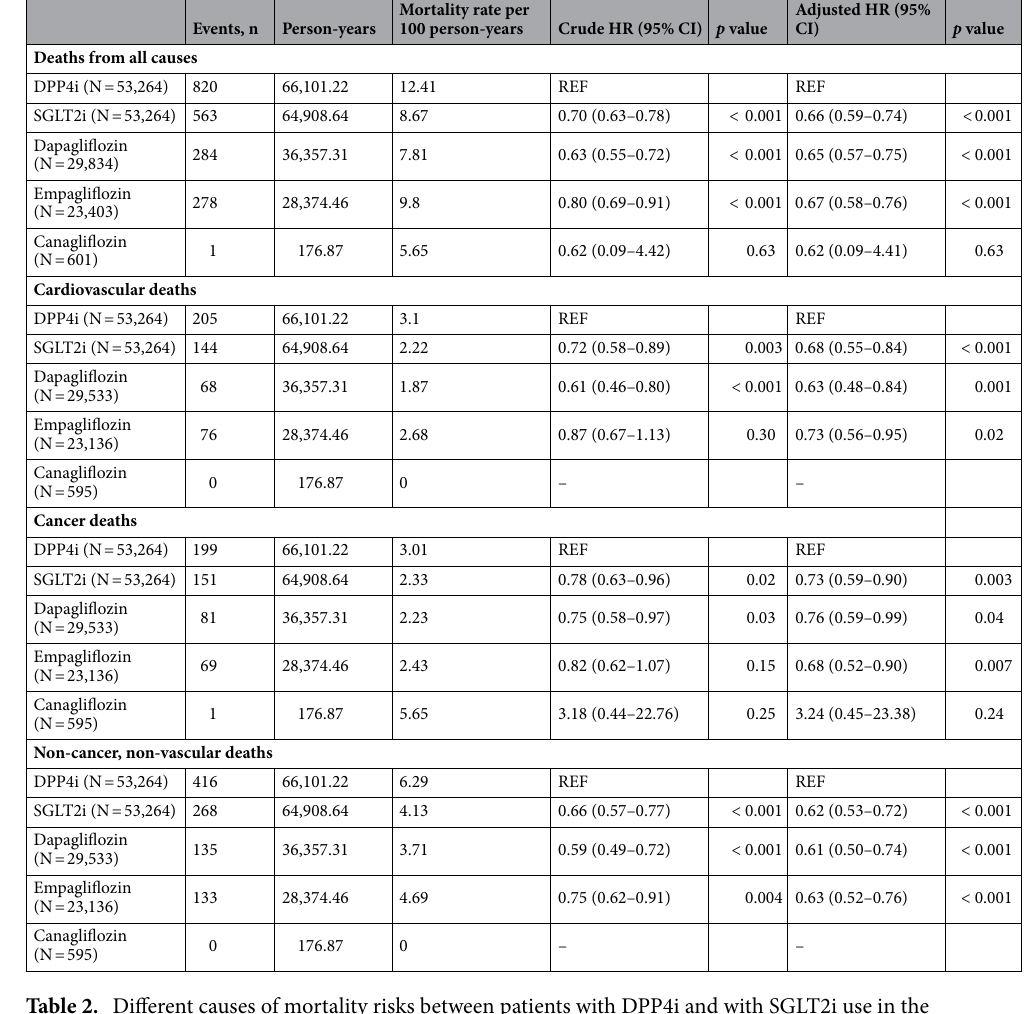
Table 2. Different causes of mortality risks between patients with DPP4i and with SGLT2i use in the propensity score matched population. Adjusted models were adjusted by age, gender, hypertension, hyperlipidemia, cerebral vascular disease, coronary artery disease, chronic kidney disease, diabetes medications usage (GLP-1 agonist, insulin, and metformin), and other medication usages (aspirin, ACEI/ARB and statin).